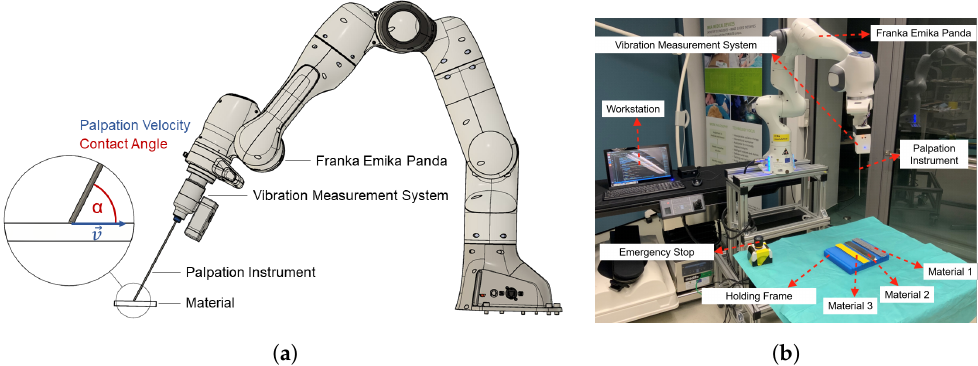
Figure 1. Schematic of the experimental setup ( a ) and implemented setup ( b ) comprising a robotic arm, an instrument with an attached vibration measurement system, and material in contact with palpation parameters (cid:126) v x and α